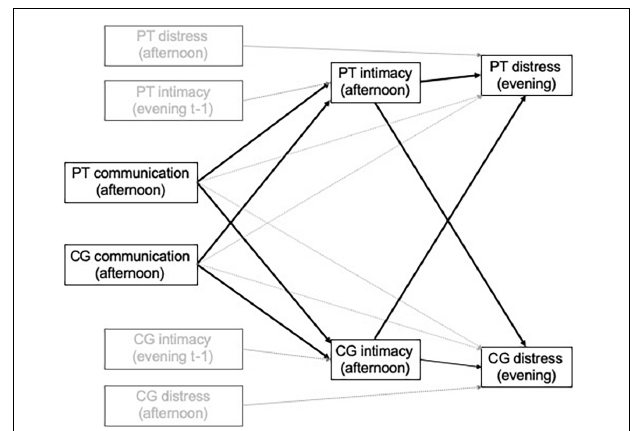
FIGURE 2 | Illustration of analytic model to examine mediating dyadic processes using ecological momentary assessment data. PT, patient; CG, caregiver. Note. Variables and paths of conceptual interest are in black; control variables and paths less central to the conceptual model are in